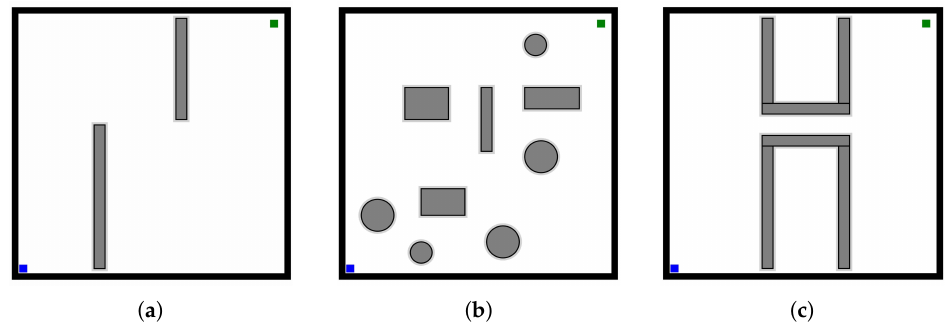
Figure 7. Three different maps. The start position is denoted as a blue point while the goal is green. ( a ) Map S.; ( b ) Map Dense.; ( c ) Map Gap.